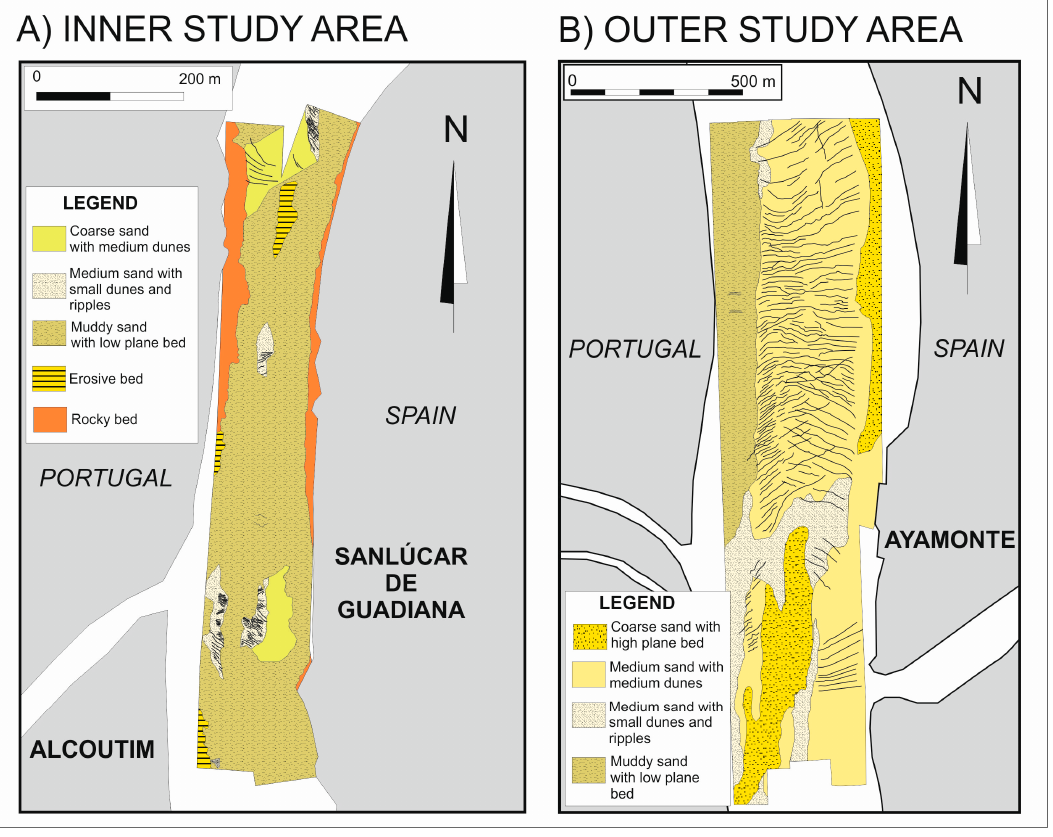
Figure 8. Map of the bed distribution and bedform crests in both studied areas: the ( A ) inner (fluvial) domain and ( B ) outer (marine) domain.